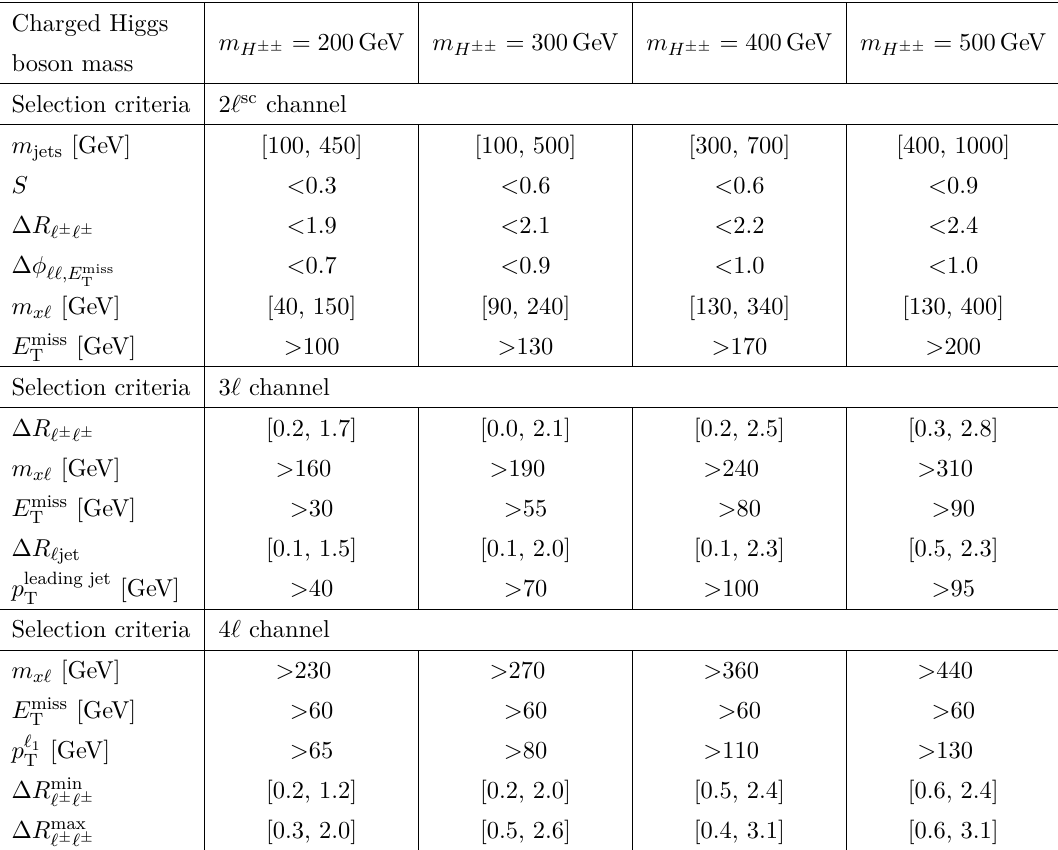
Table 5 . Definition of the signal regions optimised for the study of different H ±± and H ± mass hypotheses. The selection is applied on top of the preselection defined in table 4. For the H ±± pair production mode, the m = 300 GeVsignal regions are also used for m = 350 GeV. For H ±± H ±± the H ±± and H ± associated production mode, the m = 200 GeV, 400 GeV and 500 GeV signal H ±± regions are also used for m = 220 GeV, 450 GeV and 550 GeV, respectively. The variables used H ±± are described in section